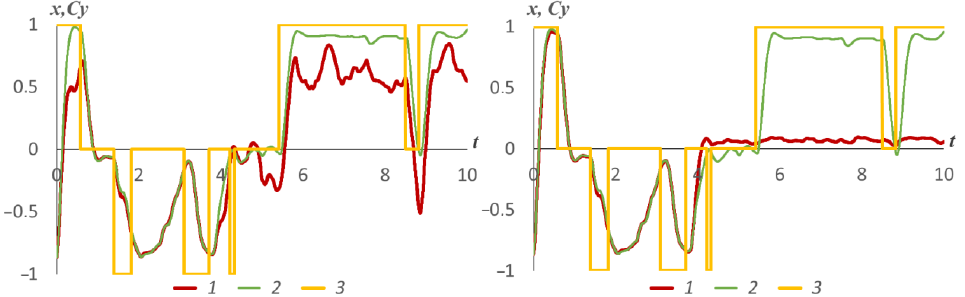
Figure 8. State trajectories governed by the various controls: ( left ) 1—system state, controlled by lim ) ; 2—system state, controlled by ˘ y δ (cid:98) u t i ( (cid:98) y t i del ) ; 2—system state, controlled by ˘ y δ (cid:98) u t i ( (cid:98) y t i